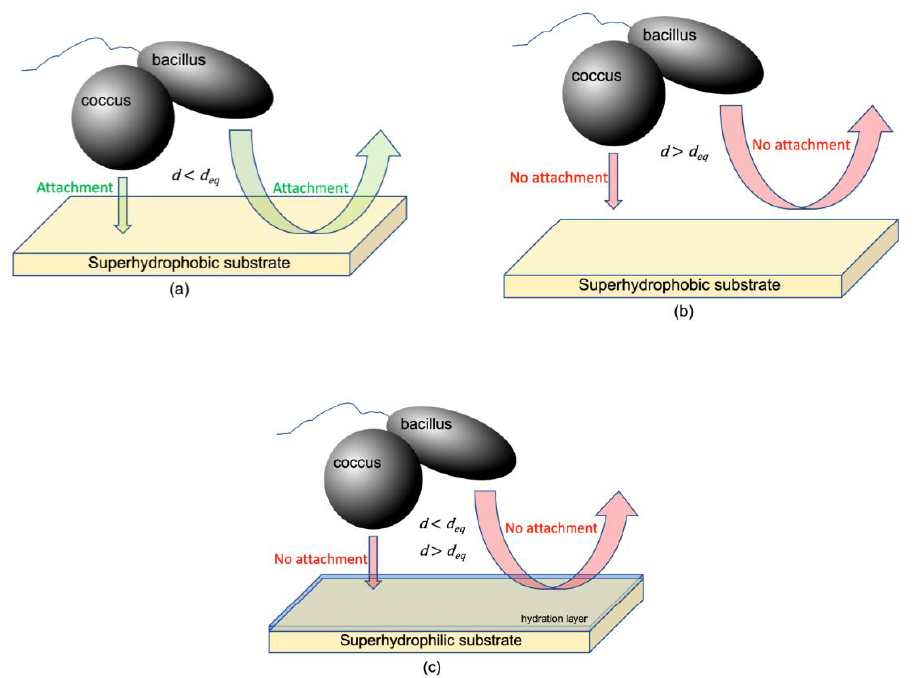
d ≤ d eq ; ( b ) superhydrophobic substrates where d > d eq ; and ( c ) superhydrophilic substrates where Figure 6. Distance dependence of bacterial attachment for ( a ) superhydrophobic substrates where d ≤ d eq and d > d eq 𝑑 ≤ 𝑑 𝑒𝑞 ; ( b ) superhydrophobic substrates where 𝑑 > 𝑑 𝑒𝑞 ; and ( c ) superhydrophilic substrates where 𝑑 ≤ 𝑑 𝑒𝑞 and 𝑑 > 𝑑 𝑒𝑞 .